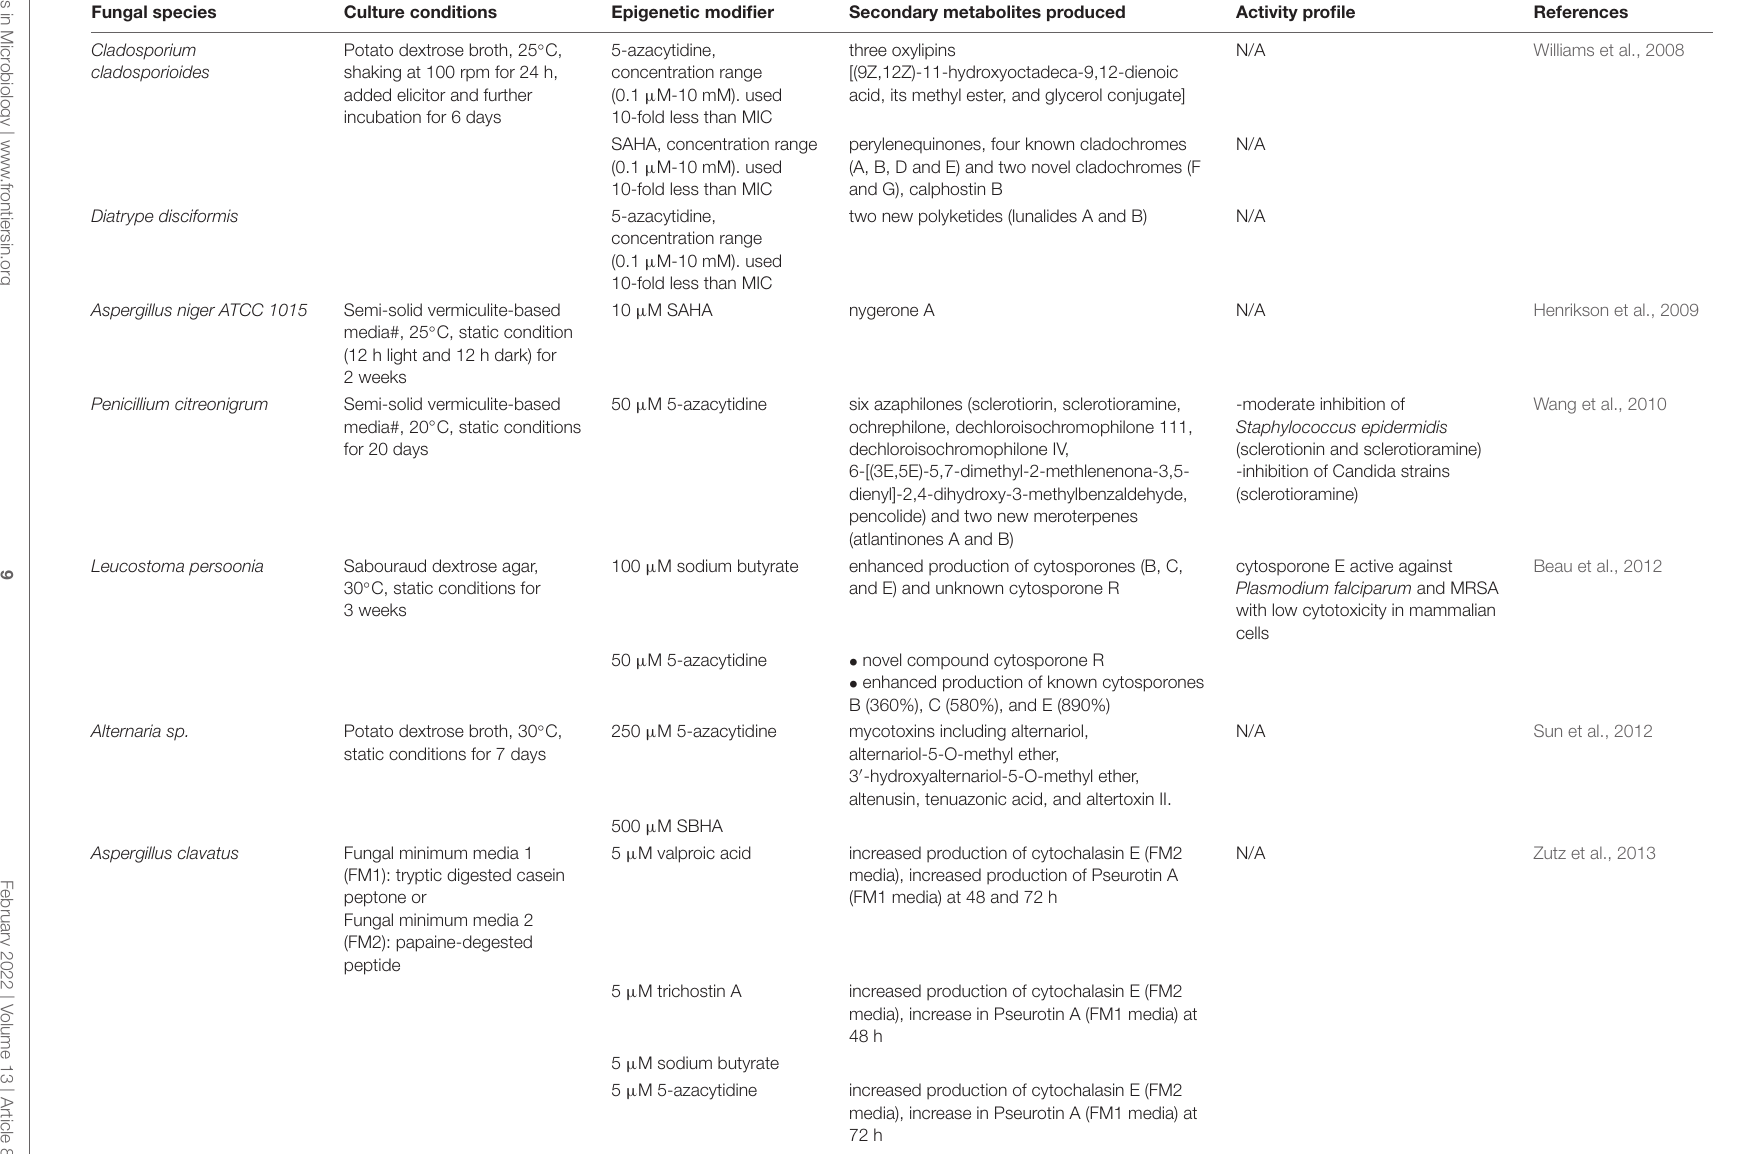
TABLE 2 | Epigenetic induction of fungal biosynthetic gene clusters encoding secondary metabolites using small molecular compounds. Fungal